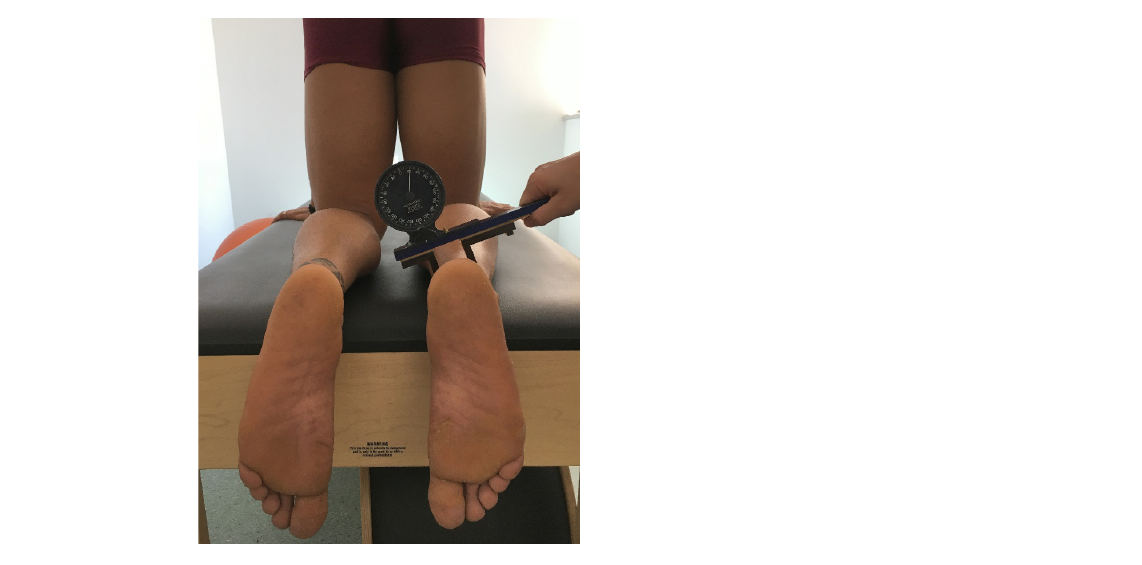
Figure 4. Subject in supine and plate of Pluri-Ped firmly pressed against sole of the foot to measure range of motion in ankle joint.